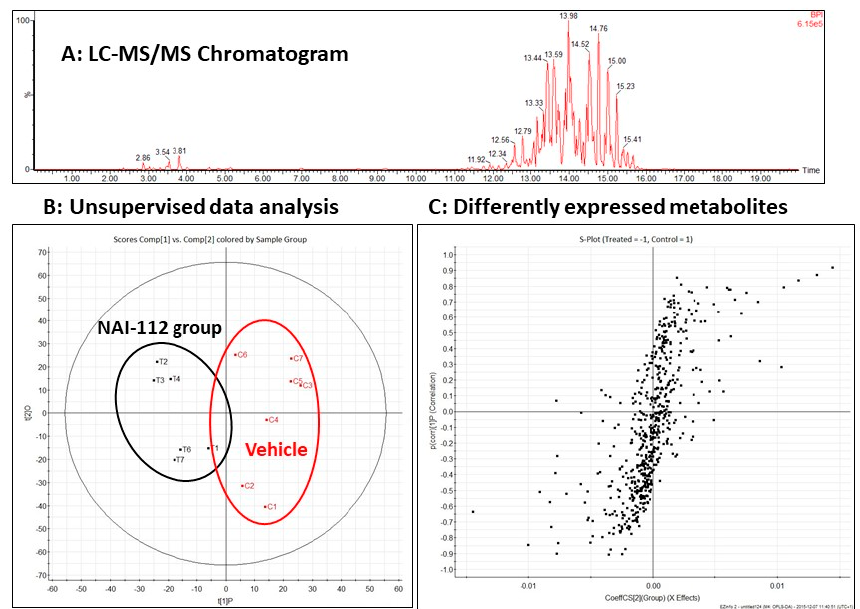
Figure 2. Lipidomic study. ( A ) Representative chromatogram of HR ‐ LC ‐ MS analysis of untargeted lipidomics. ( B ) Feature clustering using principle component analysis (PCA). Vehicle group in red shows clear separation from the NAI ‐ 112 ‐ treated group. ( C ) Orthogonal projection to latent structures–discriminant analysis (OPLS ‐ DA) was used to identify lipids differentially expressed between vehicle and NAI ‐ 112 groups.